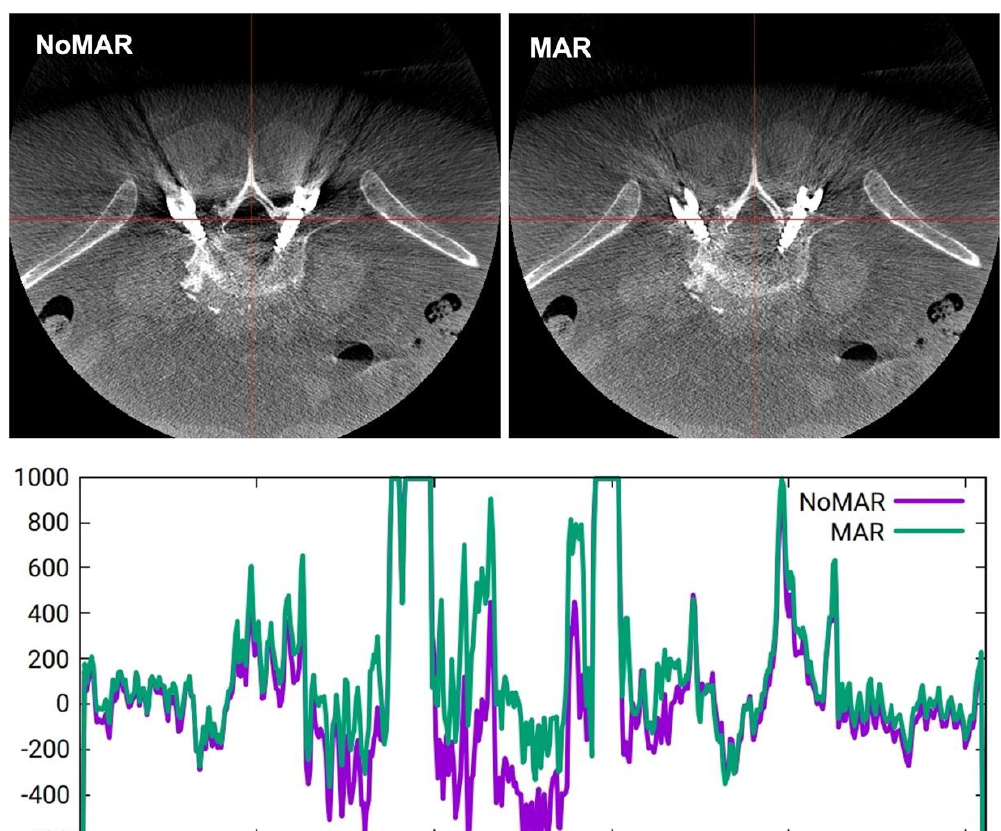
Figure 2. Variation of Hounsfield units across a coronal plane section (red line) comparing NoMAR (purple curve) and MAR (green curve).